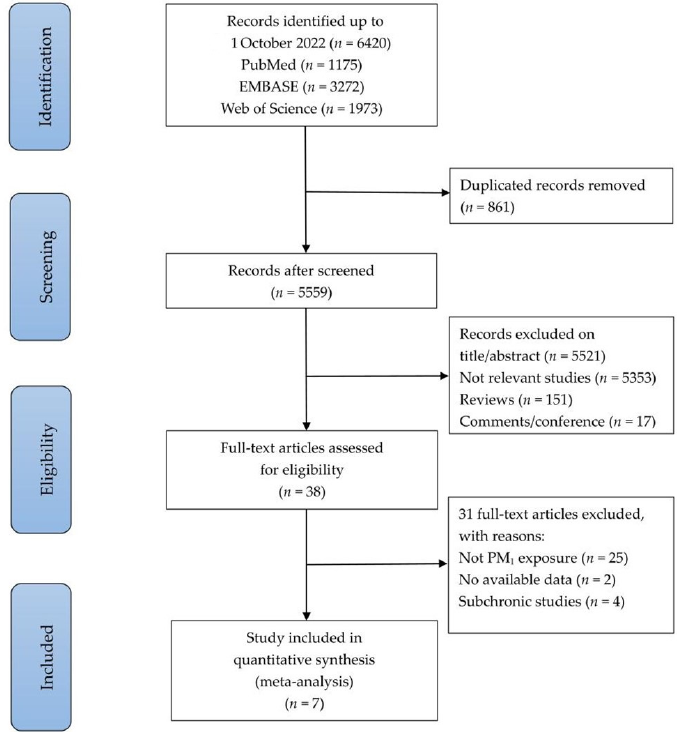
Figure 1. Flow chart of selection of studies included in the